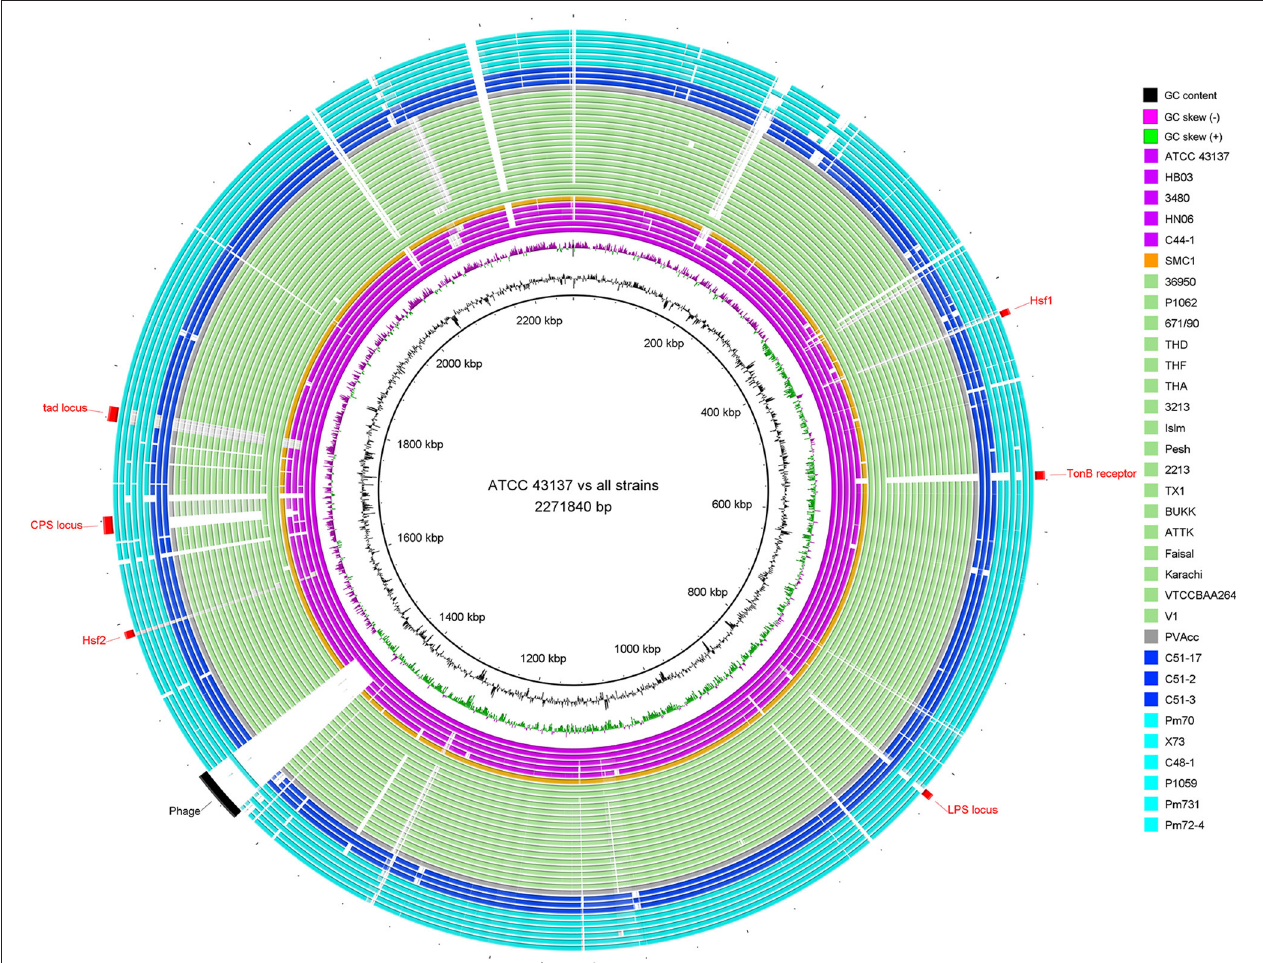
FIGURE 1 | Circular diagram of genomic sequence conservation of 33 P. multocida strains. Rings are numbered from 1 (outermost ring) to 35 (innermost ring). The outermost 33 rings show pairwise nucleotide alignment between 32 genome assemblies of P. multocida and the reference genome of P. multocida type strain ATCC 43137. Each ring is color-coded according to host origins of isolates: magenta for swine source strains, light green for bovine source strains, blue for rabbit source strains, cyan for avian source strains, orange for human source strain, and gray for strain PVAcc without host metadata. BLAST matches (minimum sequence identity of 80% and E -value cutoff of 10 − 10 ) are colored from darkest to lightest shade. The innermost ring shows mean centered GC content (outward black bar: above mean; inward bar: below mean) of the ATCC 43137 genome. The second innermost ring shows GC skew plot [(G-C)/(G + C); green indicates ratio > 0 and purple indicates ratio < 0]. Red labels and arcs denote genomic regions encoding several known virulence factors of P. multocida ; black label and arc denote a prophage region predicted by PHAST (Zhou et al.,